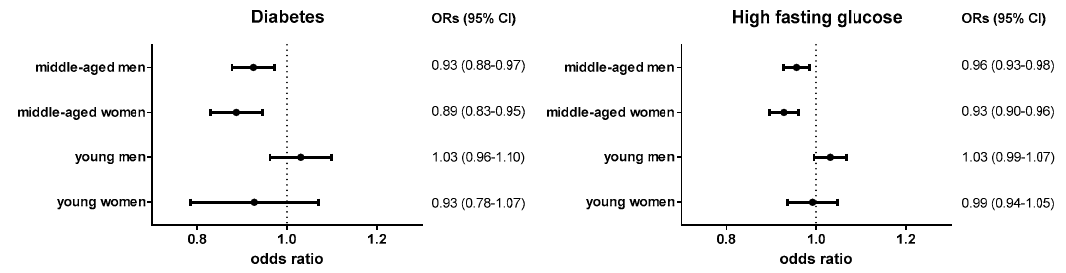
Figure2. Oddsratiosofdiabetesandhighfastingglucoseaccordingtotheamountofco ff eeconsumption. Diabetes: either fasting plasma glucose ≥ 126 mg / dL, current use of antidiabetic medication, a history of previous diabetes, or glycosylated hemoglobin (HbA1c) ≥ 6.5%; high fasting glucose: either fasting glucose of ≥ 100 mg / dL or the presence of previously diagnosed